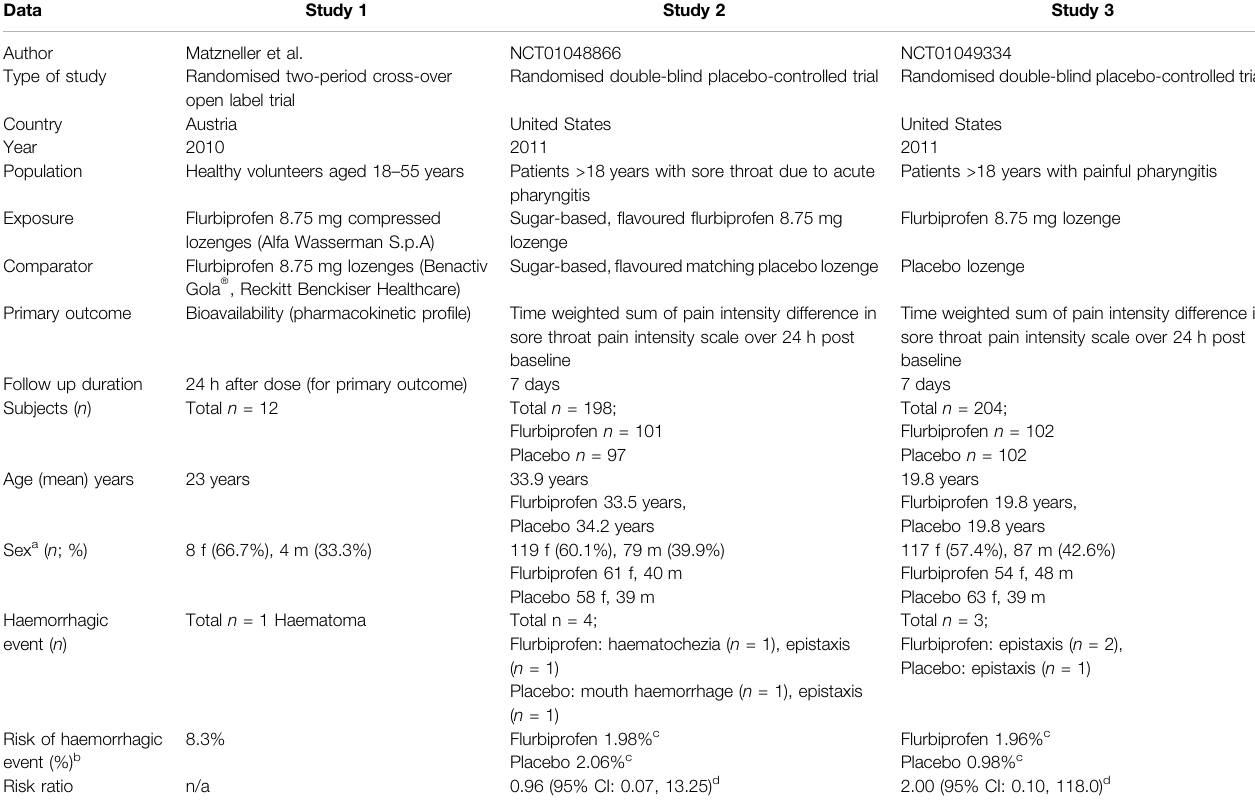
TABLE 2 | Summary of studies reporting haemorrhagic events with fl urbiprofen 8.75